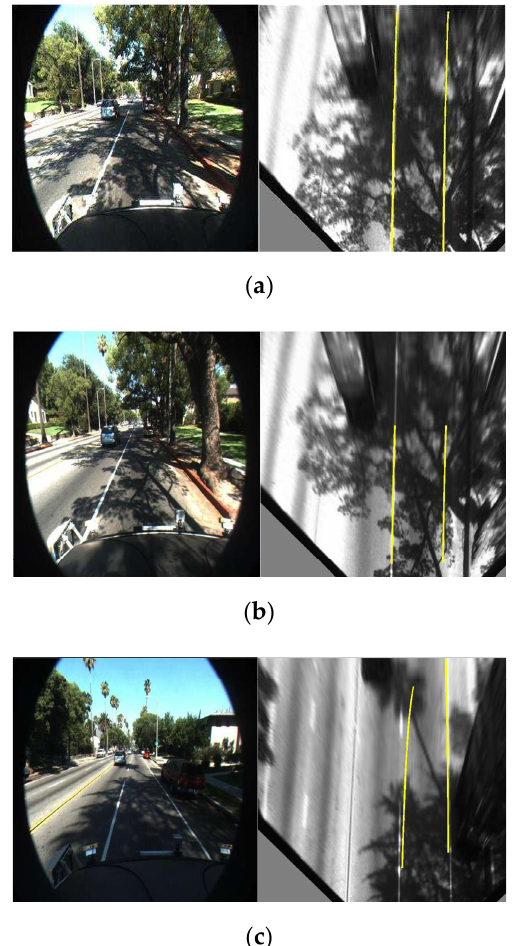
Figure 13. Effects of positive detection, missing detection and false detection: ( a ) Positive detection; ( b ) Missing detection; ( c ) False detection.